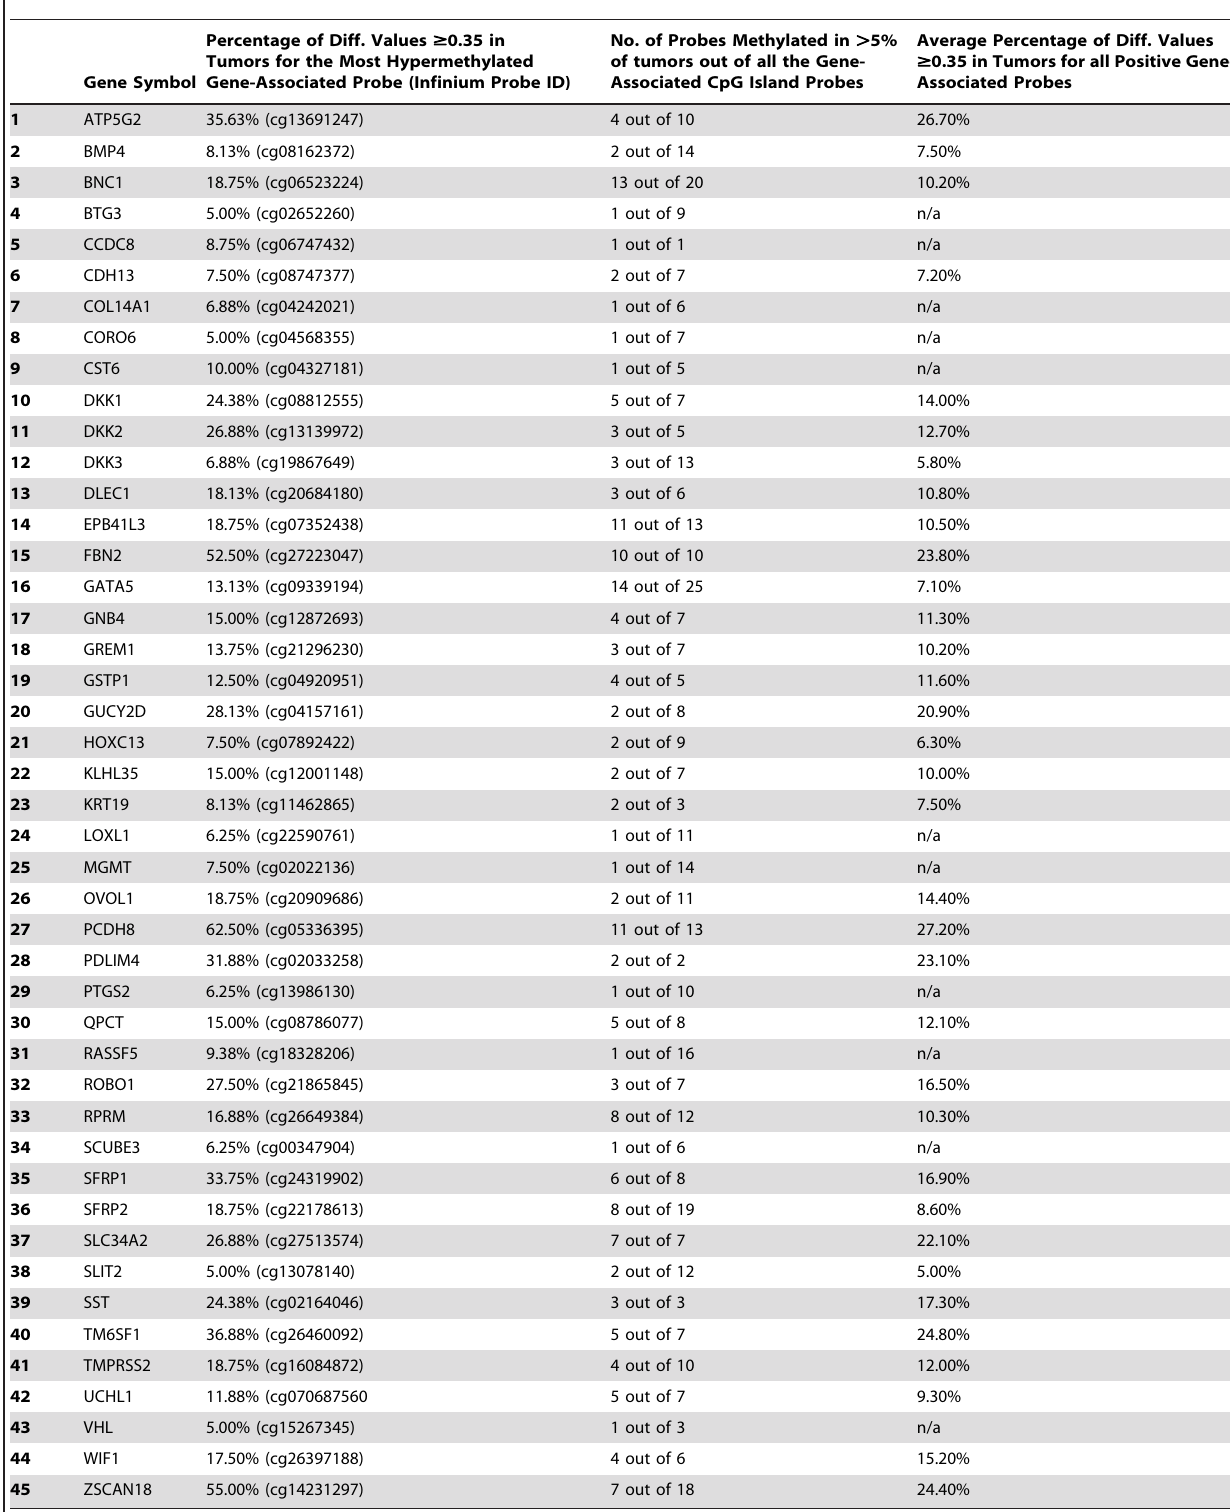
Table 2. Analysis of the Tumor-Specific Probe Hypermethylation in the Candidate Genes for the 160 TCGA RCC Tumor/Normal Pairs Present in the HumanMethylation450 BeadChip